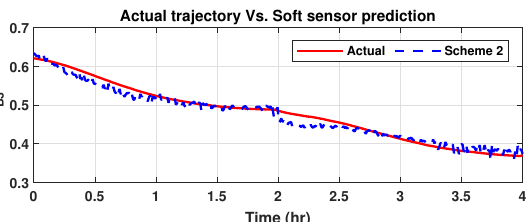
Figure 7. Trajectories of the actual states X B 3 and the predicted target variable using the soft sensor in Scheme